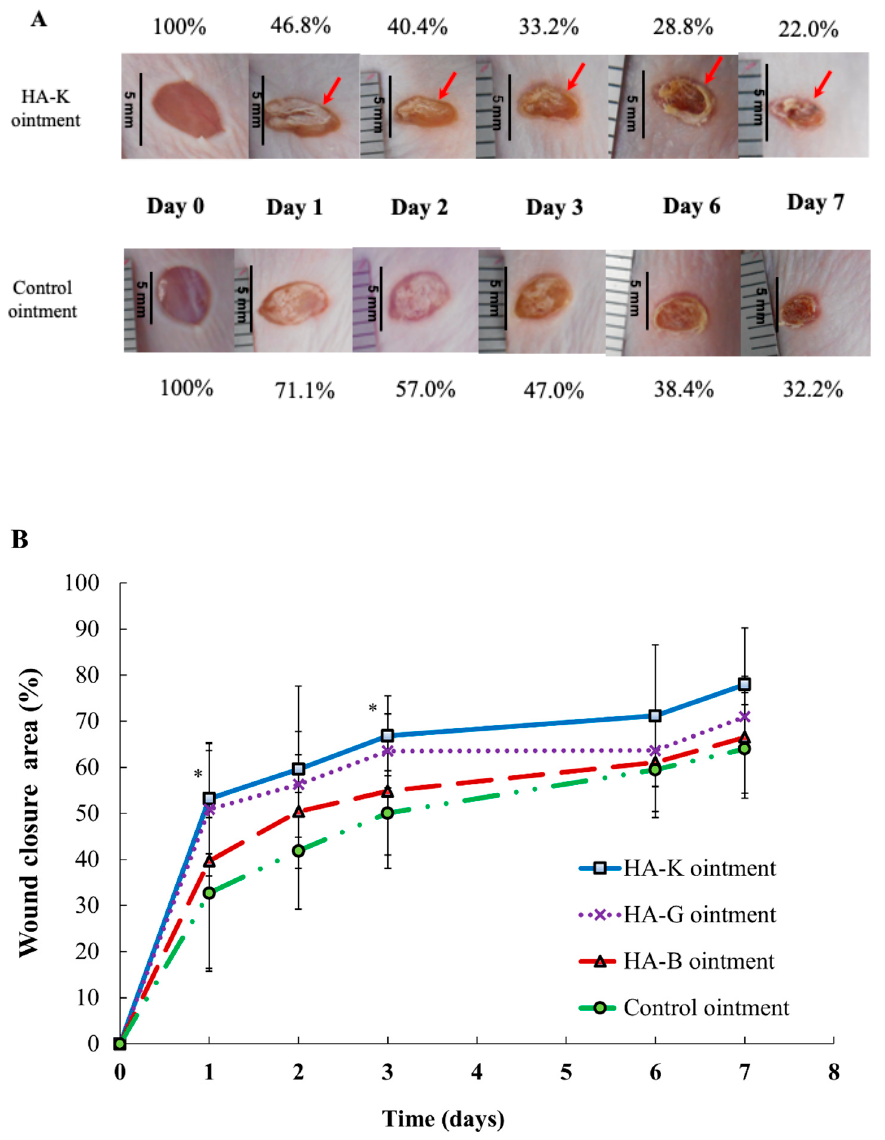
Figure 8. In vivo effects of HA ointments at 0.1% on healing of full-thickness excisional. The ointments have been applied daily. ( A ) Representative photographs for the full-thickness wounds in hairless mice at different time points. Macroscopic changes in skin wound sites induced by topical application of the control and HA-K ointment at day 0 (picture taken immediately after injury), 1, 2, 3 and 7. ( B ) Graphical representation of wound closure after topical application of control ointment (control group), HA-B, HA-G and HA-K ointment at day 0, 1, 2, 3, 6 and 7. Encrusted wound sites are represented with a red arrow. Data are expressed as percentage of wound area from the initial wound size (day 0). Values are shown as mean ± SEM ( n = 4 wounds/group), * p < 0.05 vs. control